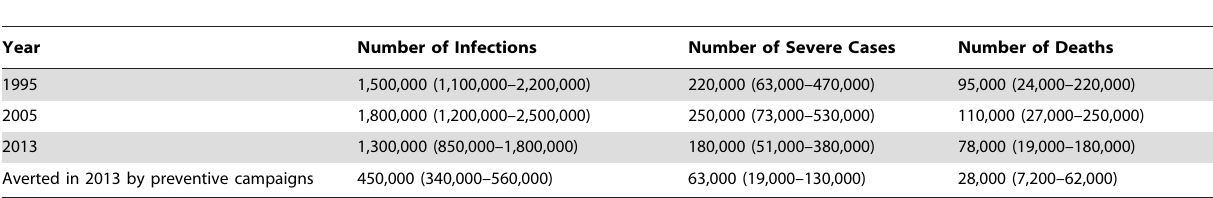
Table 2. Estimated burden in terms of the number of infections, severe cases, and deaths (95% CIs) due to yellow fever in Africa for three selected years, and the estimated burden averted for 2013 (95% CIs) due to preventive mass vaccination campaigns in Africa from 2006 to 2012.